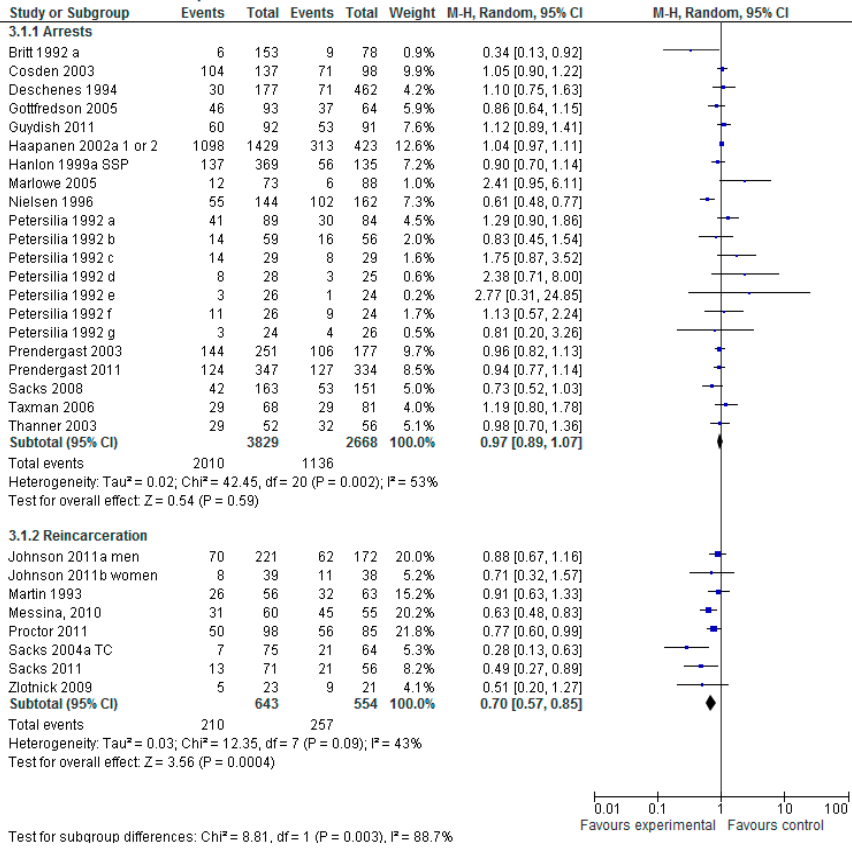
Figure 3. Does any type of Non-Pharmacological intervention reduce subsequent criminal activity?